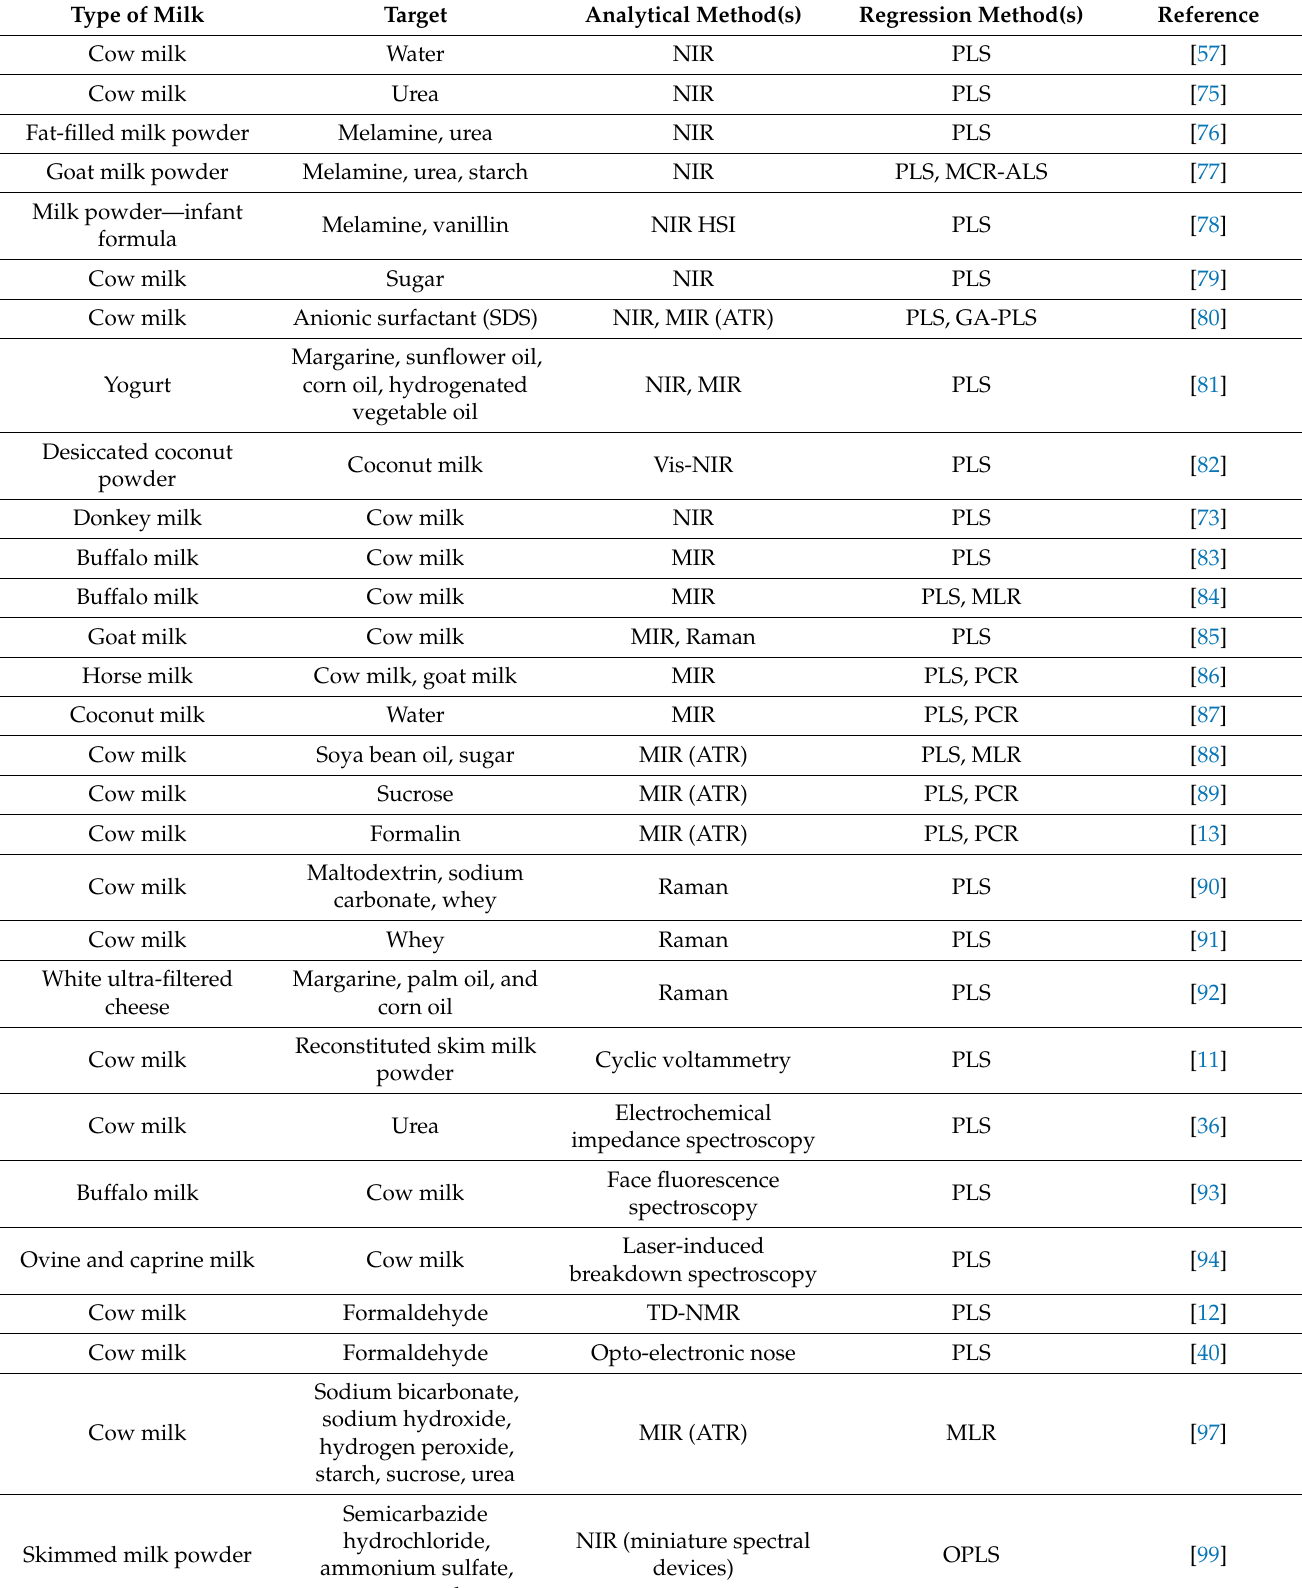
Table 4. Recent studies (2018–2022) involving regression methods related to milk